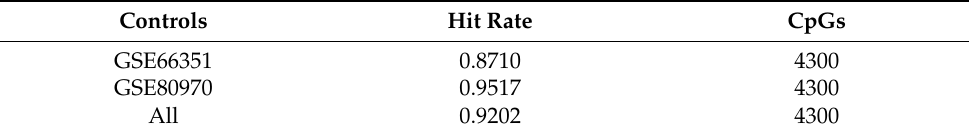
Table 8. HR of SVM for AD vs. control patients using 4300